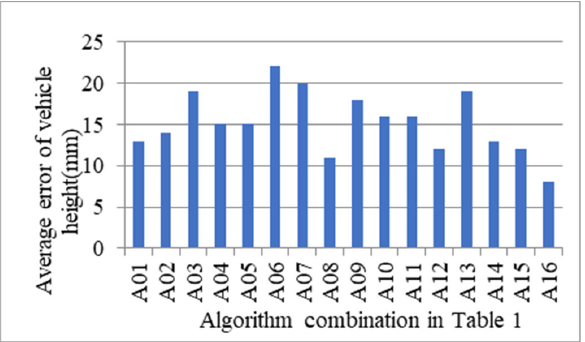
Figure 14. Average error of vehicle height according to algorithm combination in Table 1.